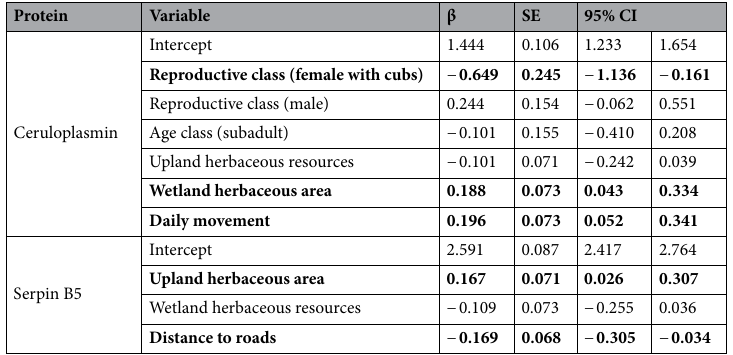
Table 4. Estimate (β), standard error (SE) and 95% confidence interval (CI) of the explanation variables in models with ΔAICc < 2 for the expression of ceruloplasmin and serpin B5 in skin samples collected from grizzly bears across Alberta, Canada. Variables with 95% CI that do not cross zero are shown in bold